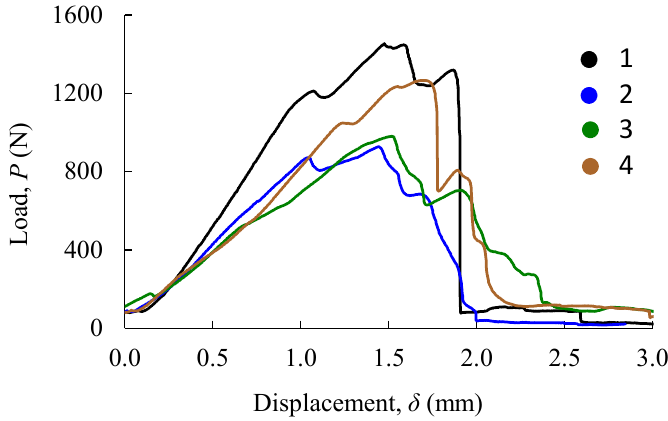
Figure 10. P ‐ δ curves obtained in pull ‐ out tests in four samples (regions). Figure 10. P - δ curves obtained in pull-out tests in four samples (regions).